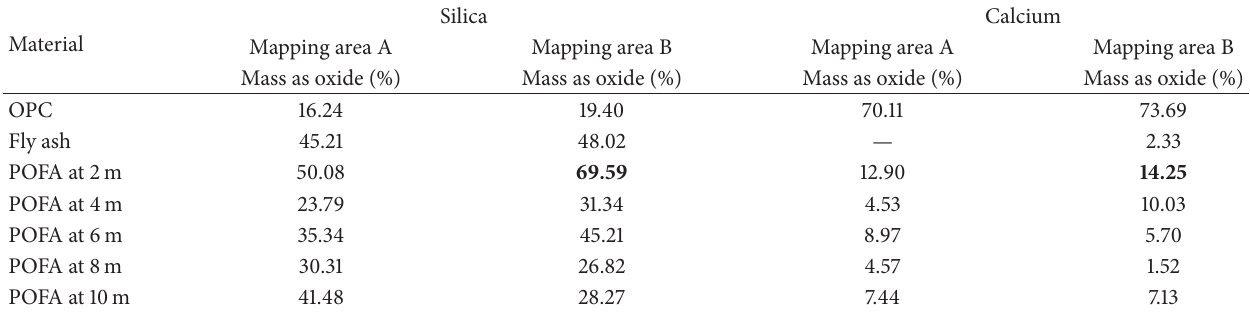
Table 3: Chemical composition of each sample from EDX